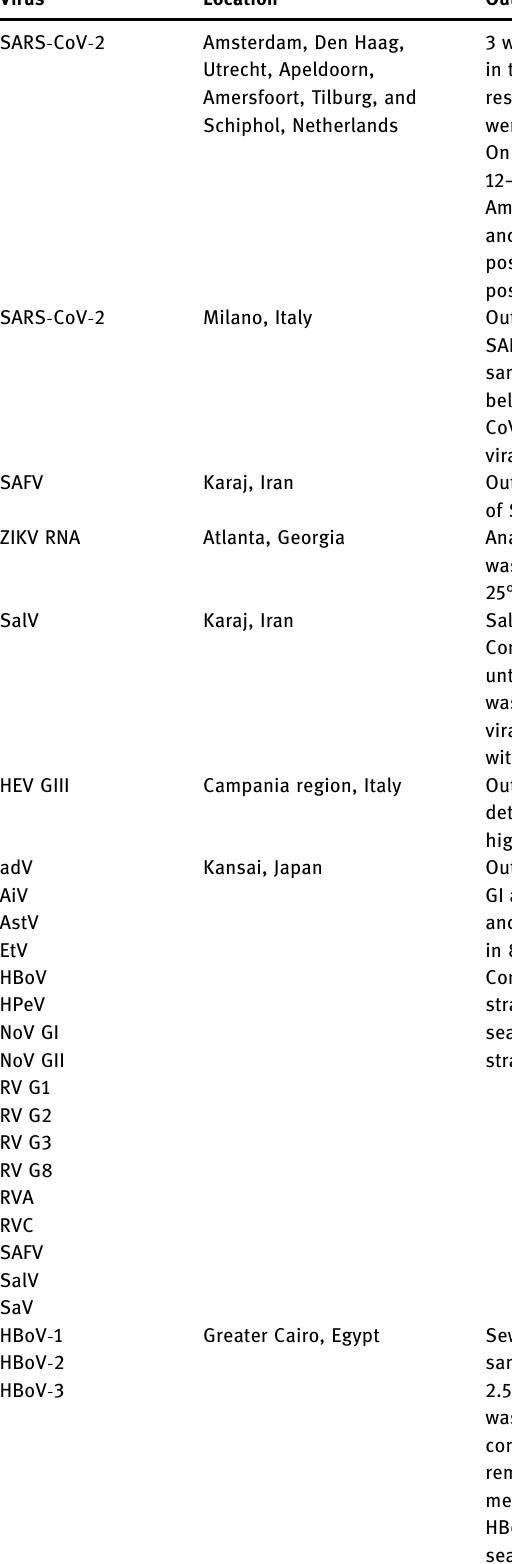
Table 1: The presence of the virus in sewage water samples Virus